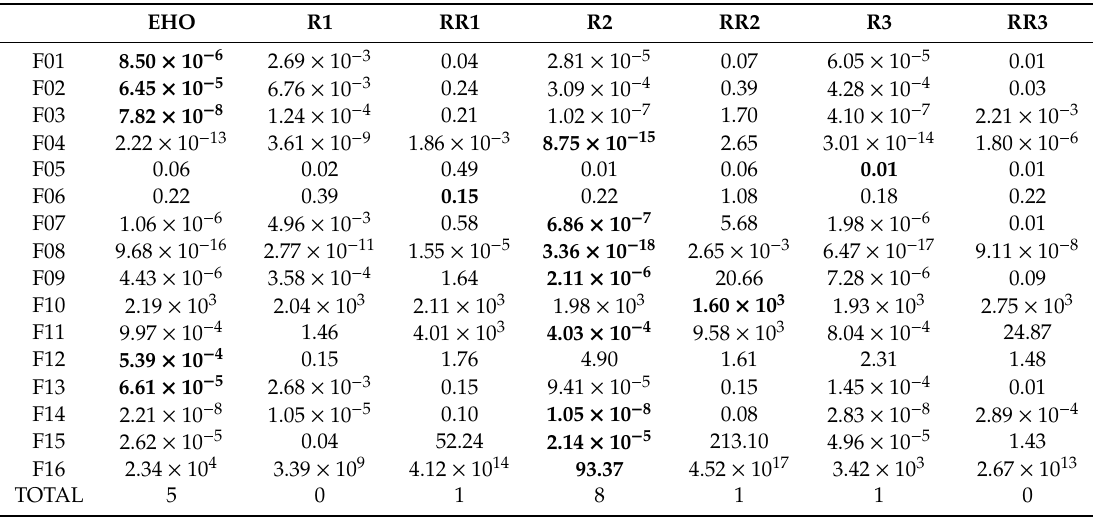
Table 11. Standard function values obtained by EHO and six improved methods with D =